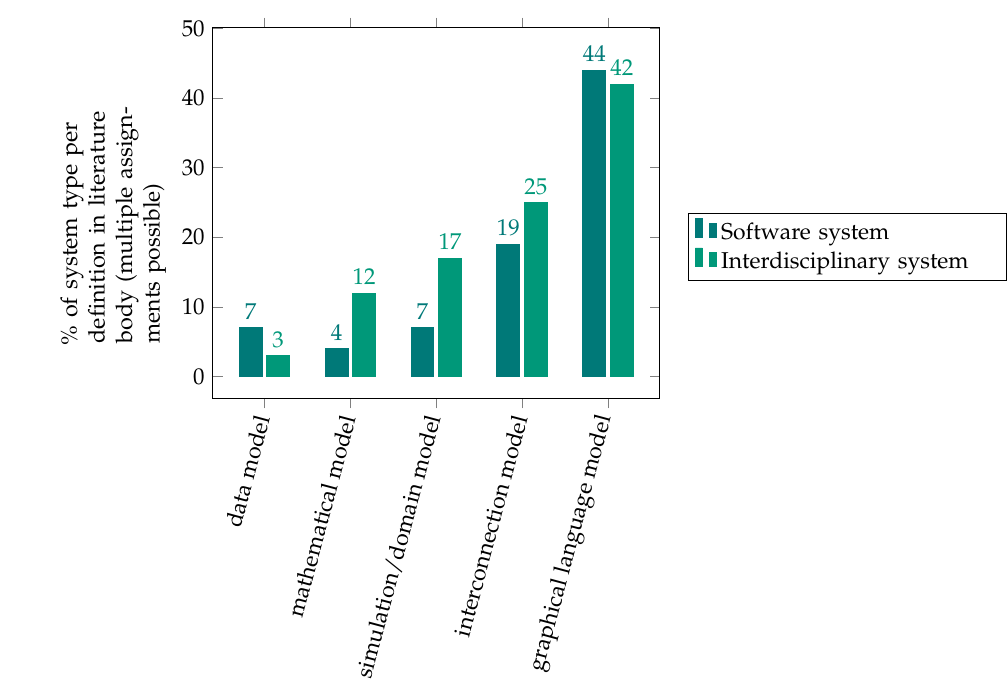
Figure 10. Distribution of system type per definition (multiple assignments